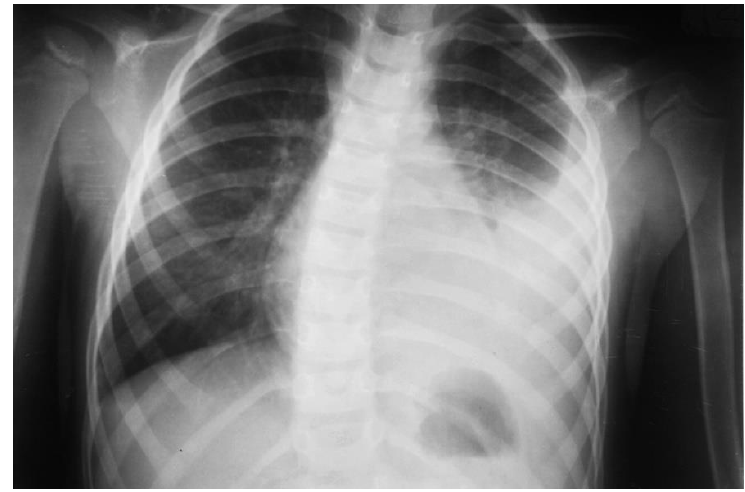
Figure 2. Left lower lobe pneumonia on CXR of the same case; no clear sign of pleurisy; apparently clear costal – diaphragmatic left angle.